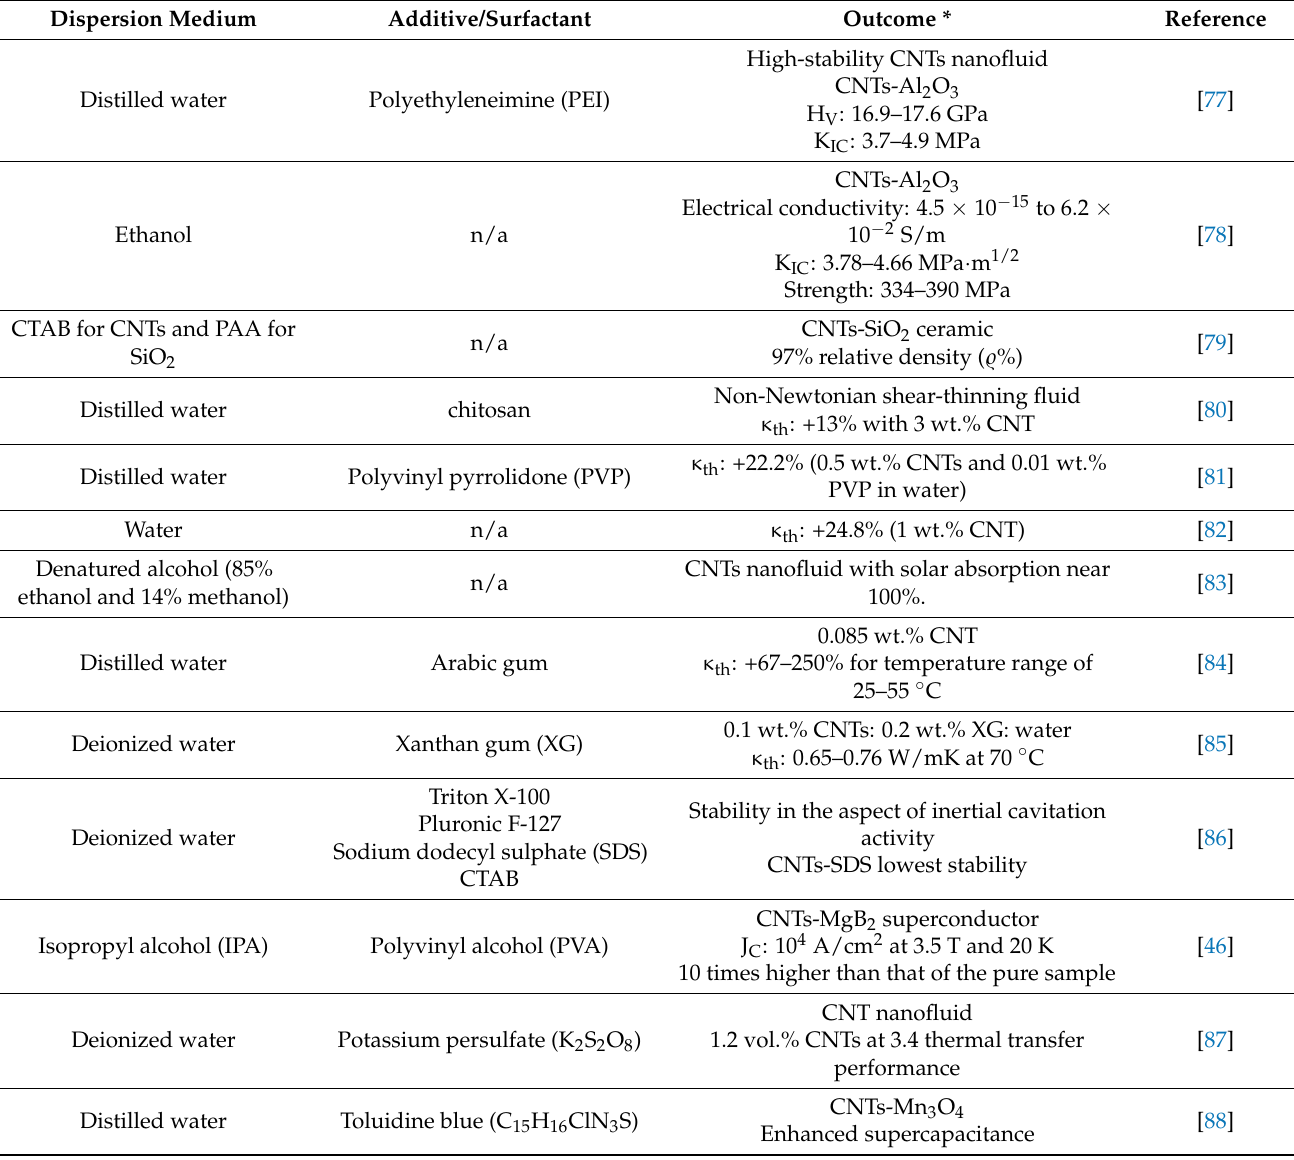
Table 1. Dispersion medium and additive added to multi-walled carbon nanotube (MWCNT)